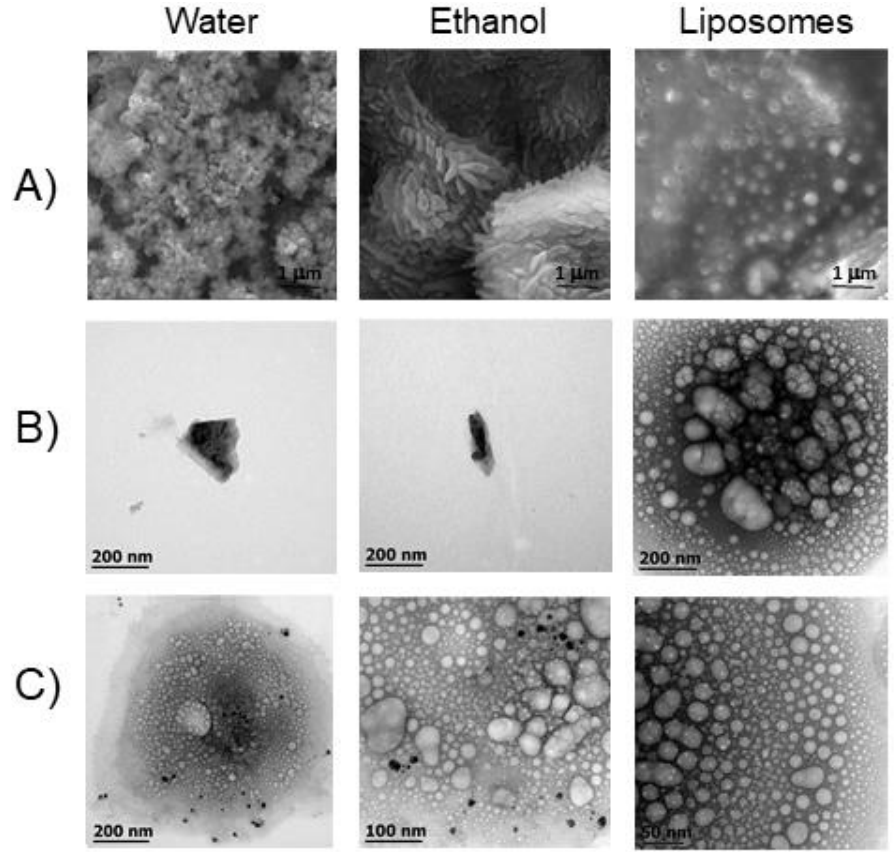
Figure 1. Liposomal encapsulation of pirfenidone. SEM and TEM images of PFD crystals in liposomes formulation, ethanolic and aqueous solutions. ( A ) SEM shows that PFD crystal shape is modified by ethanolic solution, whereas liposomal formulation completely dissolves it. ( B ) TEM images reveal that PFD crystal size is reduced by ethanol solution, compared with aqueous solution while PFD crystals are observed inside liposomes. ( C ) TEM images of liposomes containing PFD crystals are presented in different magnifications. PFD, pirfenidone; SEM, scanning electron microscopy; TEM, transmission electron